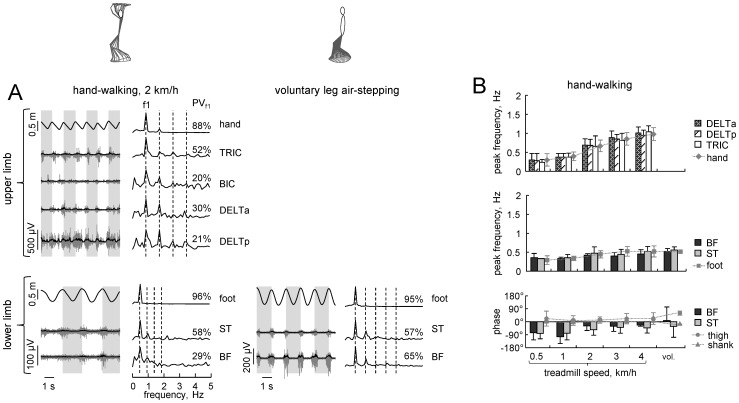
Coordination of arm and leg movements.A – arm and leg kinematics and EMGs in one representative participants performing hand-walking at 2 km/h and voluntary air-stepping. The left portion of each panel shows the oscillations of left upper and lower limbs accompanied by respective EMG activity of some representative muscles. Grey areas demarcate single limb cycles defined separately for arms and legs as the time between two consecutive maxima in the a-p displacement of the respective endpoint. The right portion of each panel displays the Fourier spectra derived from the signals on their left. Dashed lines show the position of the first five multiples of the fundamental frequency (f1) whose percentage of variance explained is displayed (PVf1). B – mean (±SD, n = 9) peak frequencies of EMGs and corresponding arm (upper plot) and leg (middle plot) kinematic patterns for hand-walking at different speeds and for voluntary leg air-stepping (vol.). Lower plot represent the phase (relative to the onset of leg cycle) of the first harmonic for leg EMGs and thigh and shank elevation angles (zero corresponds to the cosine function with zero time shift). Only EMGs with peak activity greater than 2 µV and PVf1>20% were included in this analysis.